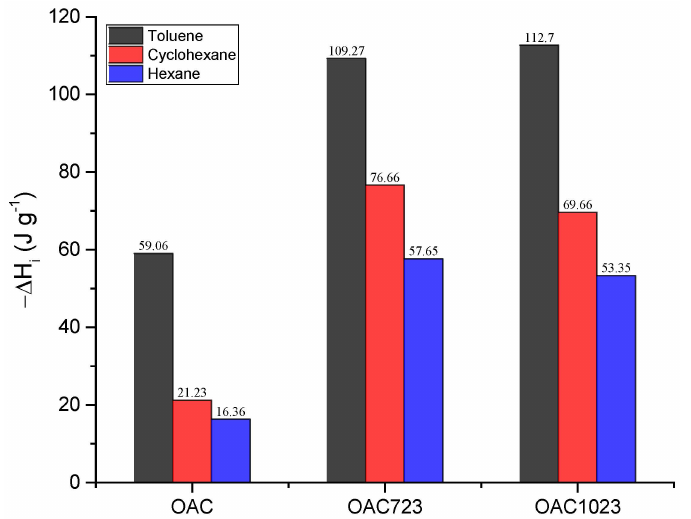
Figure 5. Immersion enthalpies of samples into toluene, cyclohexane and